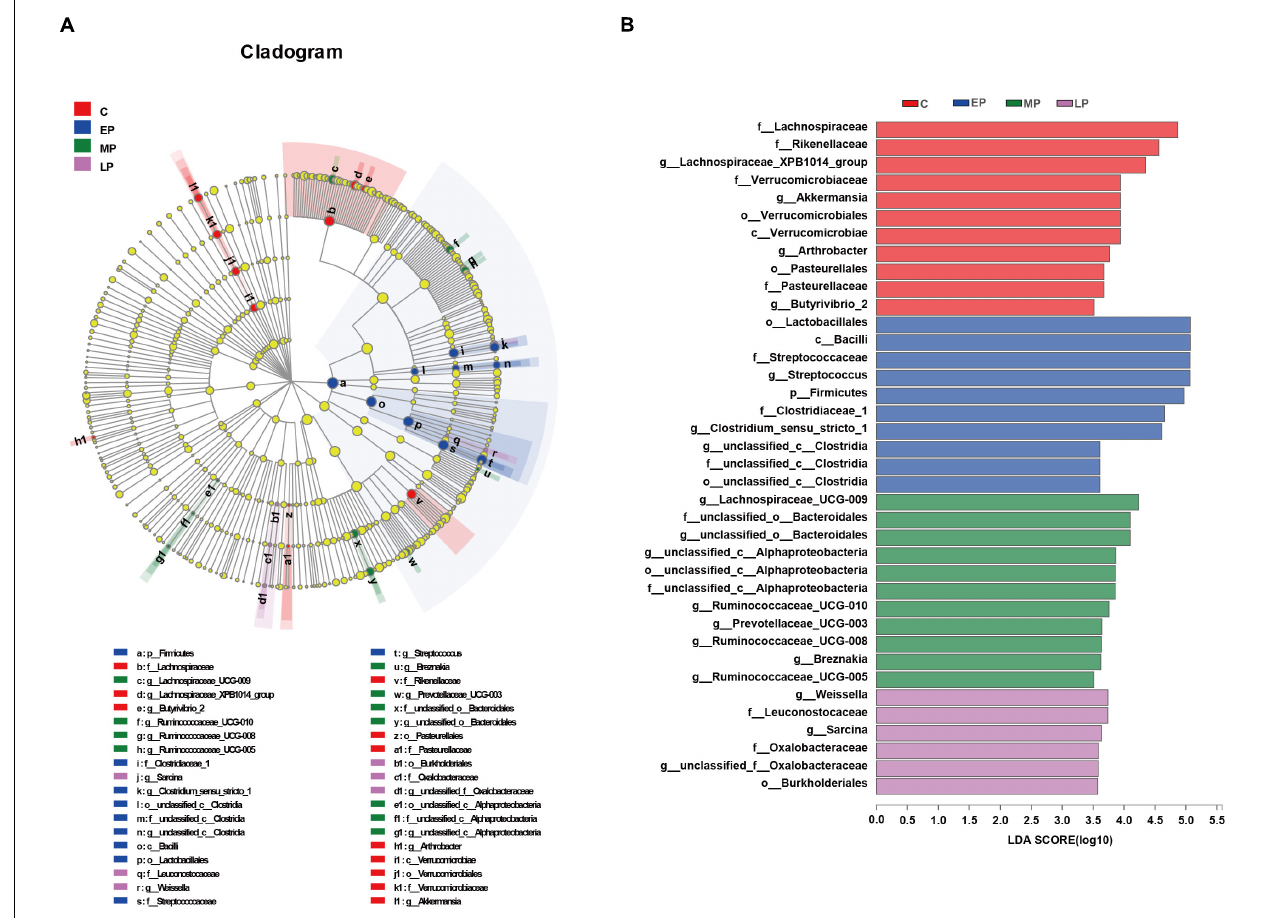
FIGURE 4 | LEfSe analysis of the gut microbial composition of Dezhou donkeys during different gestation stages. (A) Cladogram obtained from the LEfSe method, indicating the phylogenetic distribution of the gut microbiota. (B) Histogram of the LDA scores, showing the most differentially abundant taxa among different gestation stages (LDA score > 3.5, n = 6). C, non-pregnancy as a control; EP, early-stage pregnancy; MP, middle-stage pregnancy; LP, late-stage